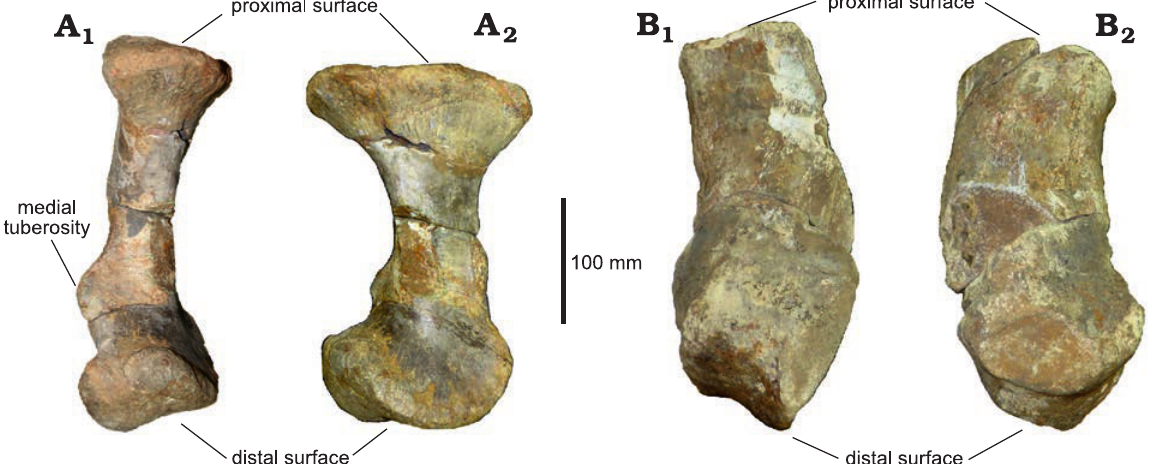
Fig. 6. Metatarsals of Lambeosaurinae indet. (FCBUANL_2711) from Ejido Presa San Antonio, Coahuila, Mexico, upper Campanian. A . Metatarsus II, in dorsal (A 1 ) and lateral (A 2 ) views. B . Metatarsus IV, in dorsal (B 1 ) and lateral (B 2 )